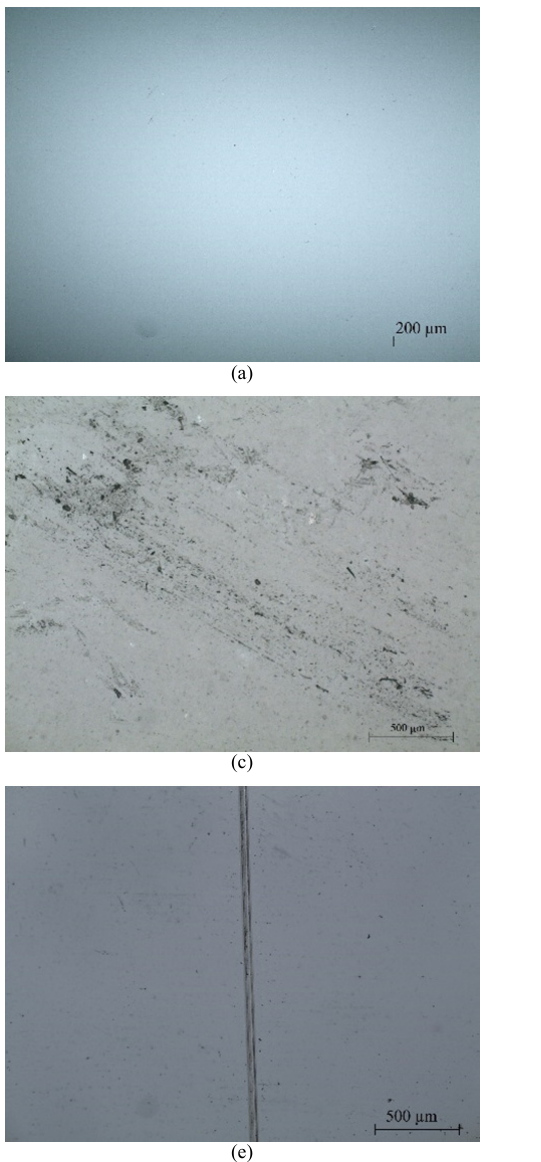
Fig. 5 Optical microscopy of the: (a) as-received annealed glass - tin side (AR); (b) internal “protected” surface of the naturally aged glass (NA); (c) outer “exposed” surface of the naturally aged glass (NA); (d) sand abraded glass (SA b ); (e) the scratched glass with a blunt indenter (SC a ) and; (f) the scratched glass with a sharp indenter (SC b